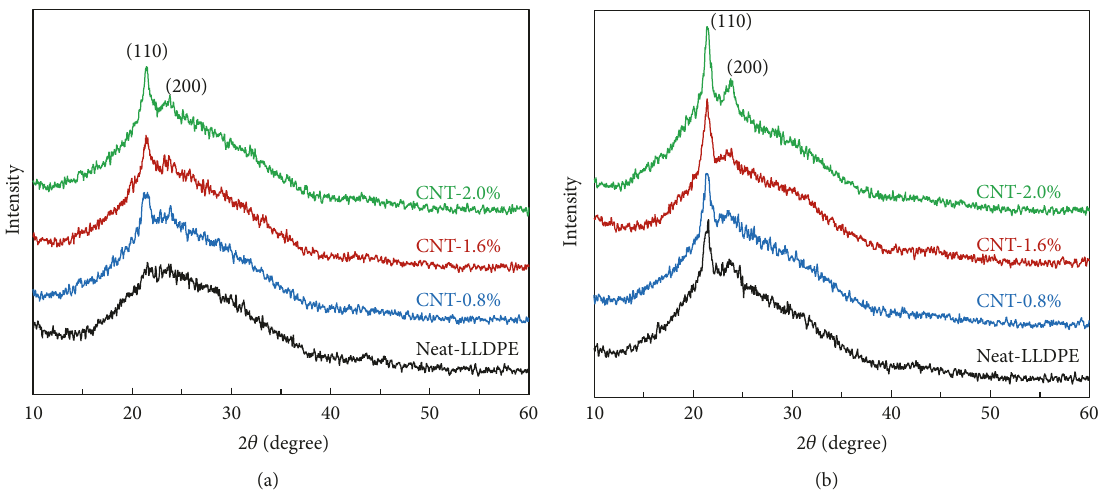
Figure 1: X-ray diffraction patterns of LLDPE fiber as a function of CNTs content: (a) undrawn LLDPE fiber; (b) heat drawn LLDPE fiber (DR 4).